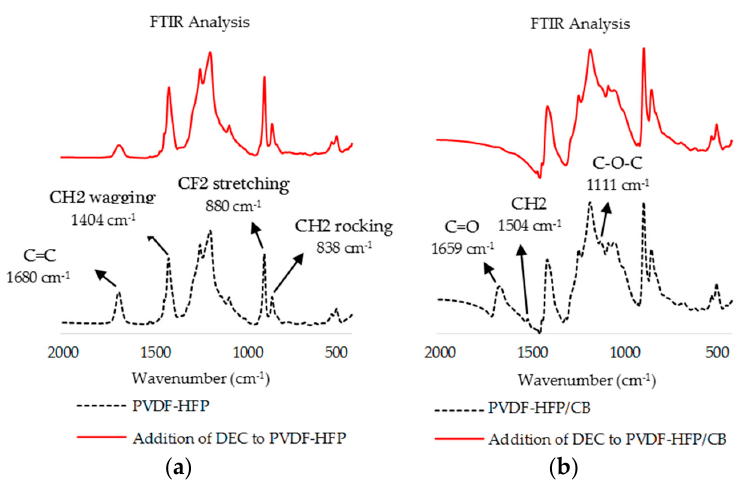
Figure 6. FTIR analysis of ( a ) PVDF-HFP (in dotted black) and PVDF-HFP after addition of DEC (in solid red); ( b ) PVDF-HFP/CB (in black) and PVDF-HFP/CB after addition of DEC (in solid red).